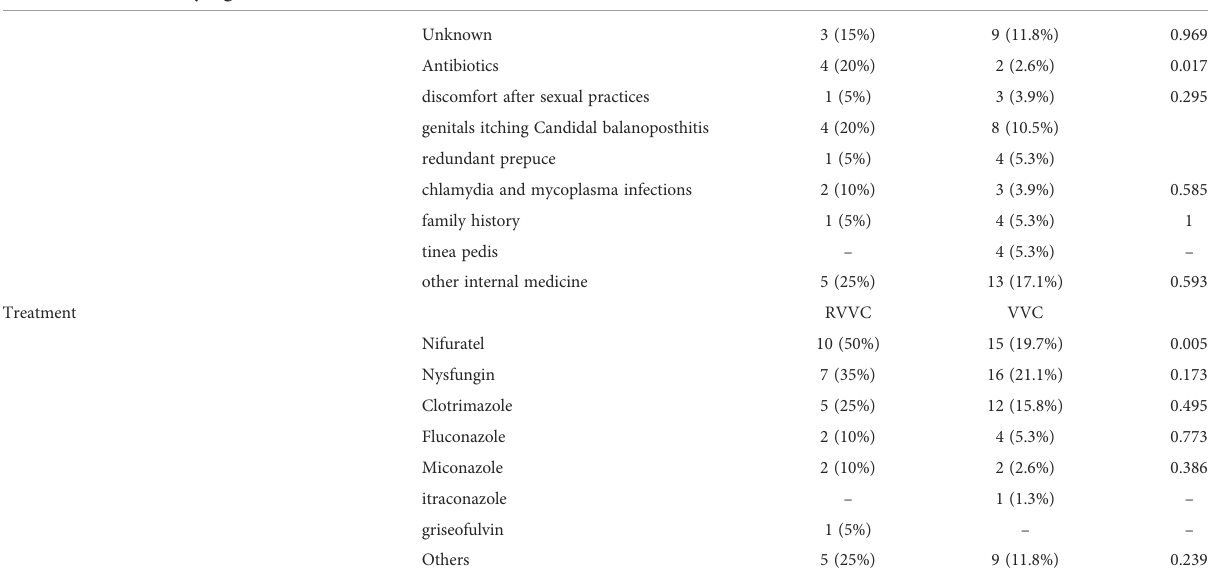
TABLE 2 Risk factors of the RVVC group and VVC